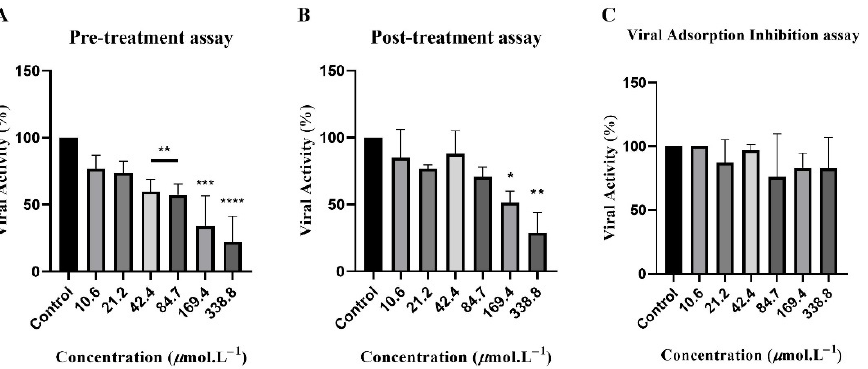
Figure 4. Mechanism of action assays. ( A ) Pre-treatment assay. Vero cells were pre-treated with compound 9 and subsequently infected with MAYV (MOI 1). Cells were incubated for 48 h, at 37 ◦ C. ( B ) Post-treatment assay. MAYV-infected Vero cells were treated with different dilutions of compound 9. Cells were incubated for 48 h, at 37 ◦ C. ( C ) Viral adsorption inhibition assay. A MAYV dilution (MOI 1) was mixed with different serial dilutions of the compound and added to Vero cells and incubated at 4 ◦ C for 2 h and then moved to incubation for 48 h, at 37 ◦ C. The viral activity was defined by lysis plaque counts and normalized to percentage considering control as 100% in all assays. The values obtained in Viral Adsorption Inhibition assay were non-significant. **** p < 0.0001; *** p < 0.001; ** p < 0.01; * p < 0.05.